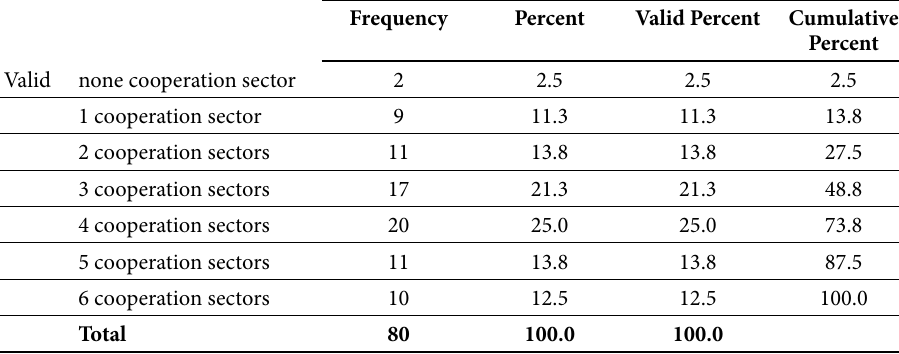
Table 3. Number of cooperation sectors amongst Latvian tourism enterprises, 2004